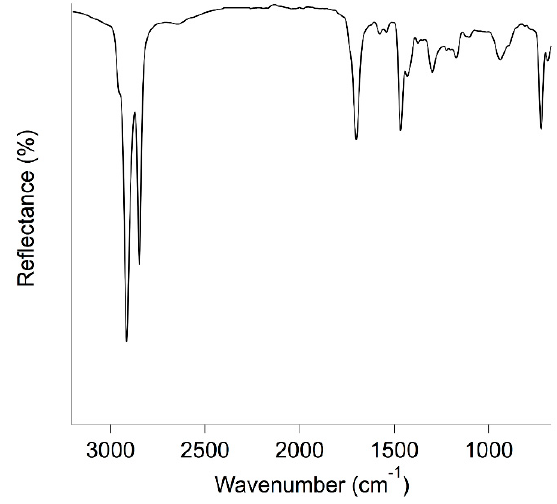
Figure 5. ATR spectrum of wax from Major Chapel of the S. Croce basilica, Florence.